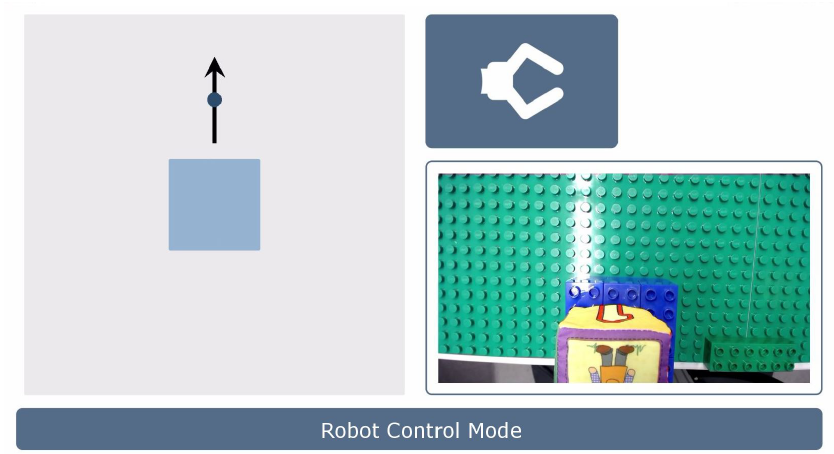
Figure 5. Graphical User Interface during Robot Control Mode. The GUI displays an icon of the current robot group (top right), the image of the gripper camera (bottom right), an information line (bottom) and feedback about the current head angle given by the arrow (left). The square represents the deadzone in which the robot arm cannot be moved.